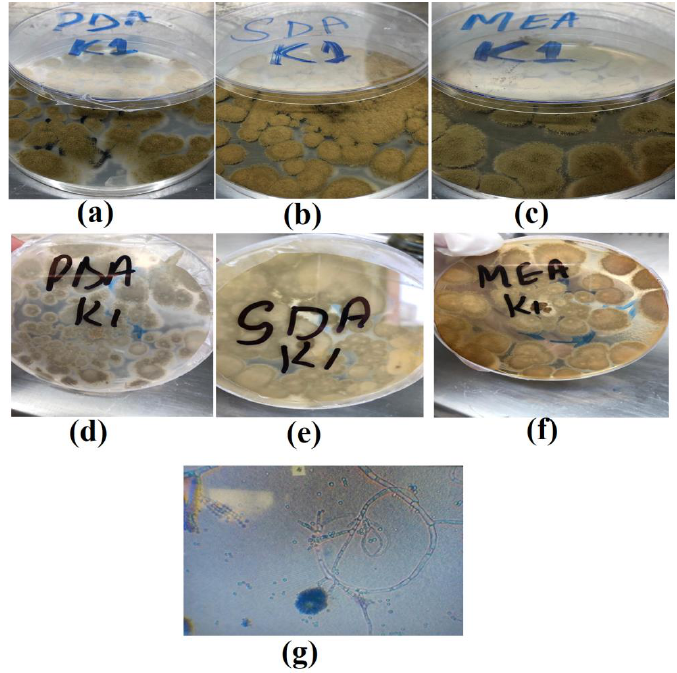
Figure 1. Morphological identification of the K1 strain on PDA, SDA, and MES media (( a , b , c ,) front; ( d , e , f ) back; ( g ) the chains of mycelium and spores).